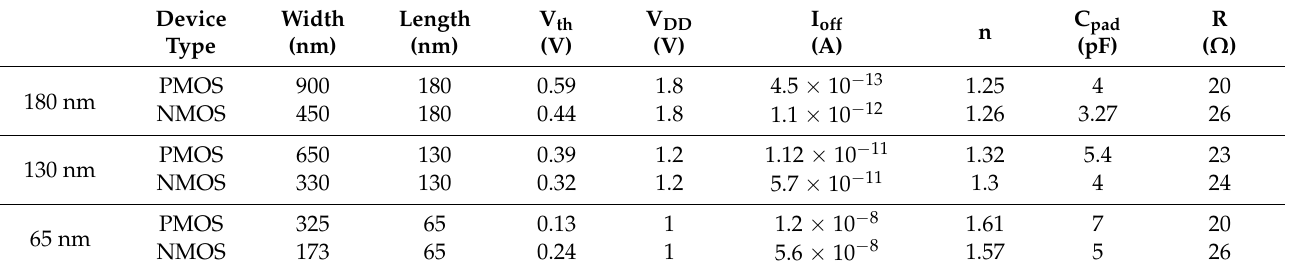
Table 2. Transistor sizes and